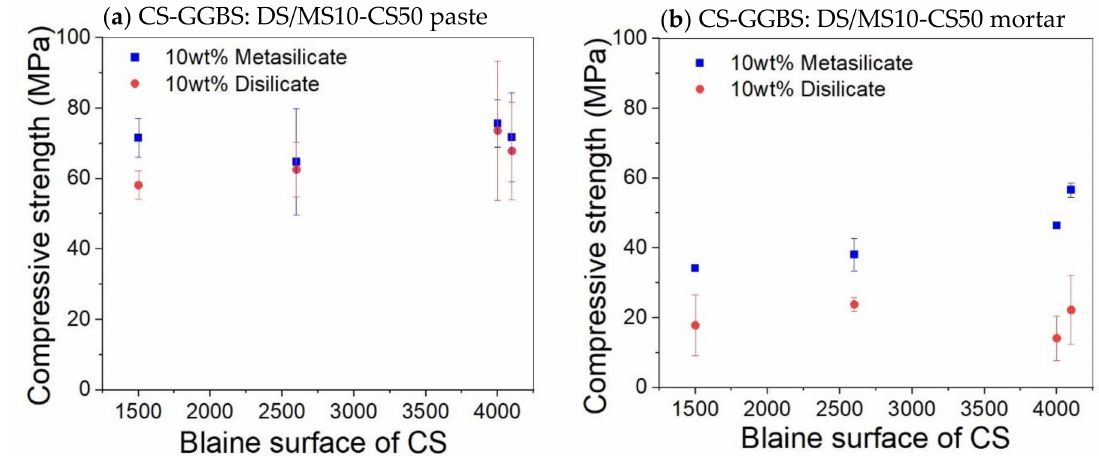
Figure 5. Effect of Blaine surface on the compressive strength of paste ( a ) and mortar ( b ) based on composition 8: DS10-CS50 and MS10-CS50.